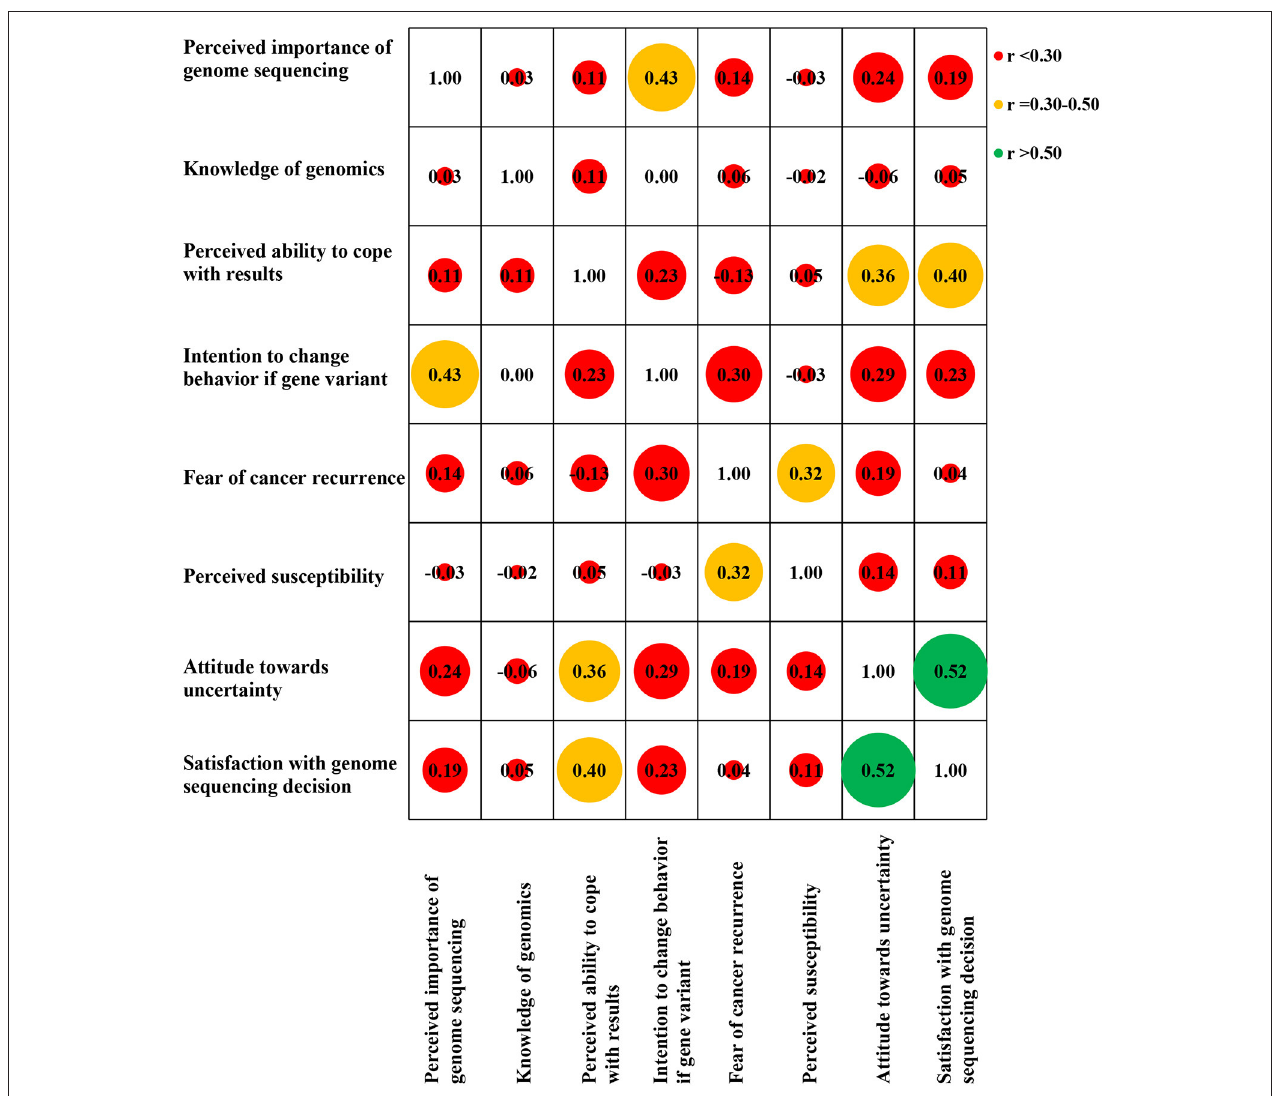
FIGURE 1 | Baseline (T0) variables correlation matrix heat map (Pearson correlation